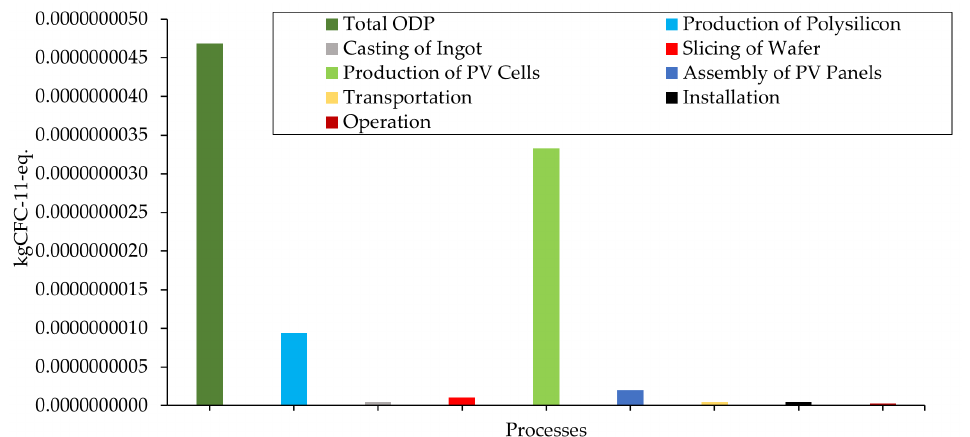
Figure 9. Ozone layer depletion potential .